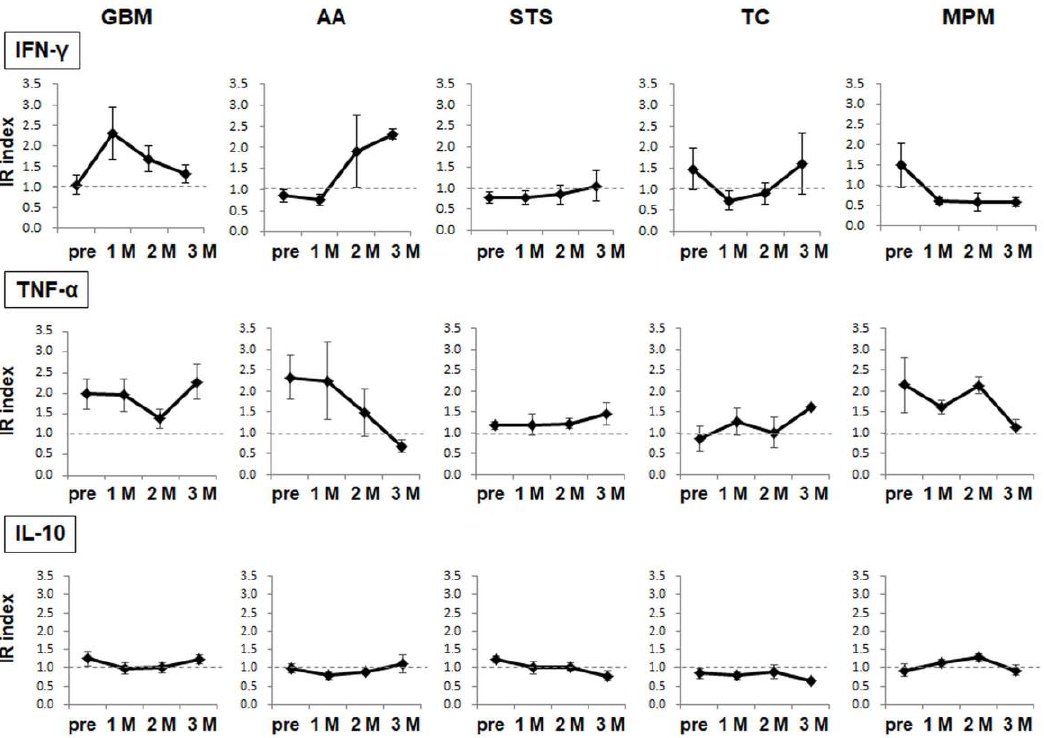
Figure 3. WT1-specific cellular immune responses. The target epitope WT1-235-specific cytokine production/release from PBMCs was analyzed using the ELISPOT assay. The results are indicated in the IR index for each cytokine. The circles and error bars indicate the average and standard error, respectively.